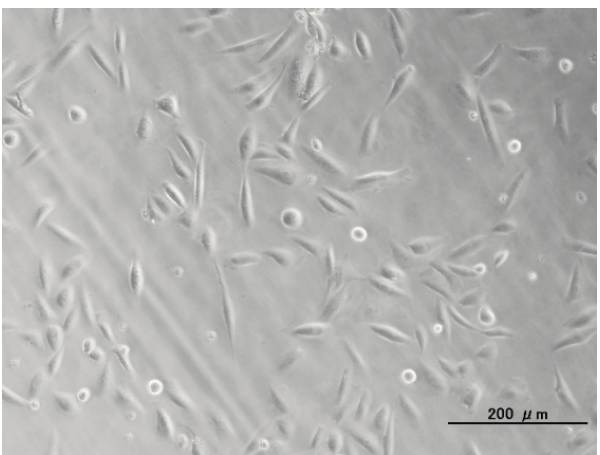
Figure 6. Optical microscopy image of CHO-K1 cells cultured on the DNA–fibronectin–apatite composite layer (DF-Ap layer) immobilizing firefly luciferase ( FL ) gene (Sample DF-FL). The scale bar indicates 200 μ